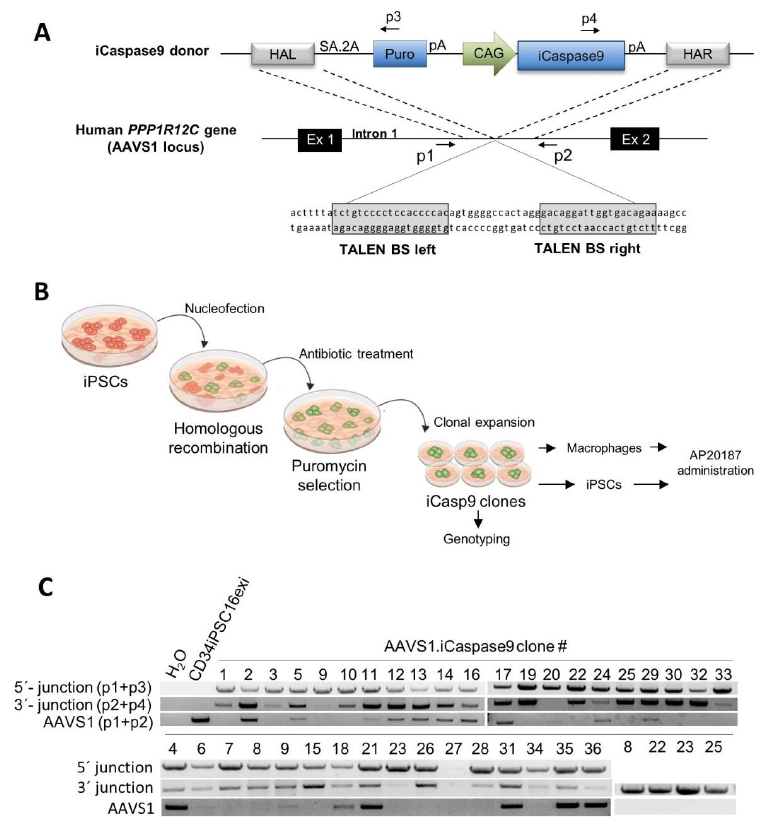
Figure 1. Generation and genotyping of adeno-associated virus integration site 1 (AAVS1)-targeted human induced pluripotent stem cells (iPSCs). ( A ) Scheme of the AAVS1 target site and the iCasp9 donor. The donor template targets intron 1 between exon 1 and exon 2 of the AAVS1 locus. The inducible Caspase 9 (iCasp9) is expressed from the CMV early enhancer / chicken ß-actin promoter (CAG) promoter. Arrows indicate the primers (p1-p4) that are used for genotyping. ( B ) Experimental set-up of the generation and processing of iPSC clones targeted with the iCasp9 transgene within the AAVS1 site. ( C ) PCR-based verification of the site-specific integration of the donor cassette in 36 puromycin-selected iPSC clones. HAL—homology arm left; HAR—homology arm right; SA—splice acceptor; 2A—self-cleaving peptide; Puro—puromycin resistance gene; CAG—CMV early enhancer / chicken ß-actin promoter; pA—poly-A site; BS—binding